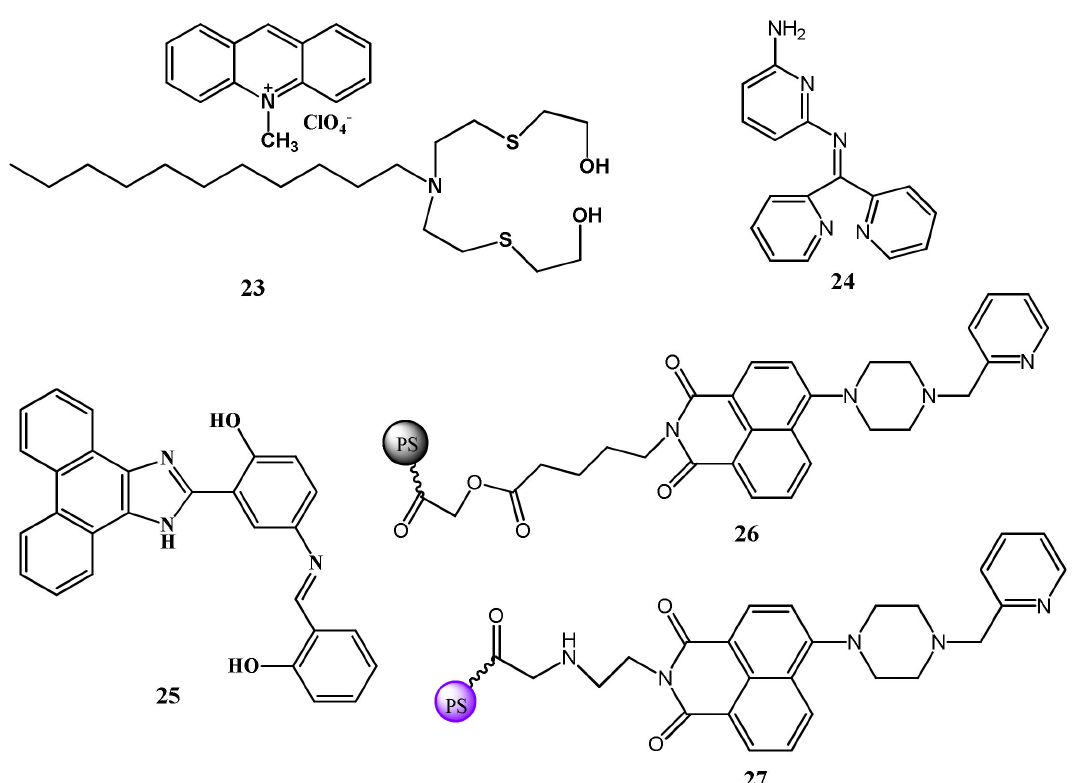
Figure 9. Molecular structures of the sensors 23 to 27